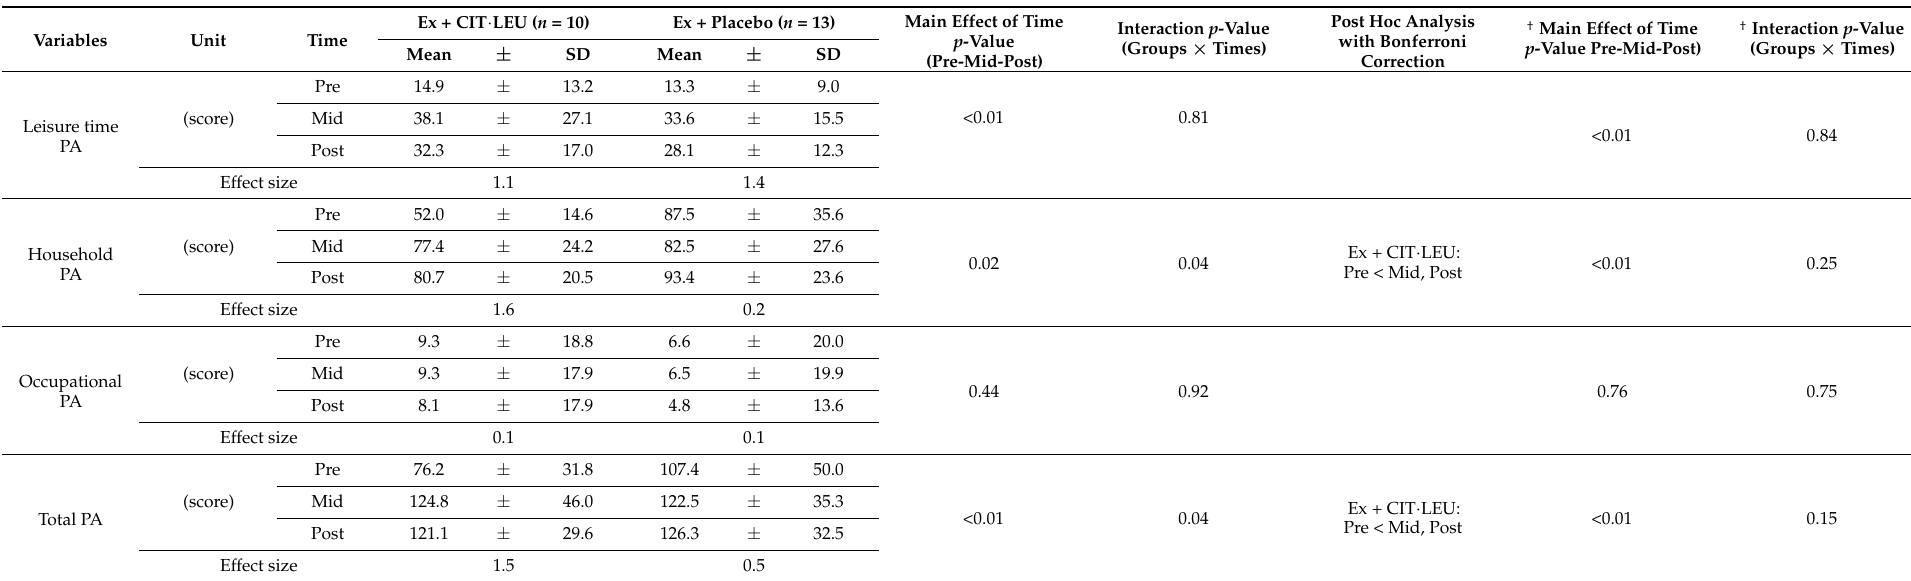
Table 4. Effects of amino acids (CIT and LEU) intake and multicomponent exercises on physical